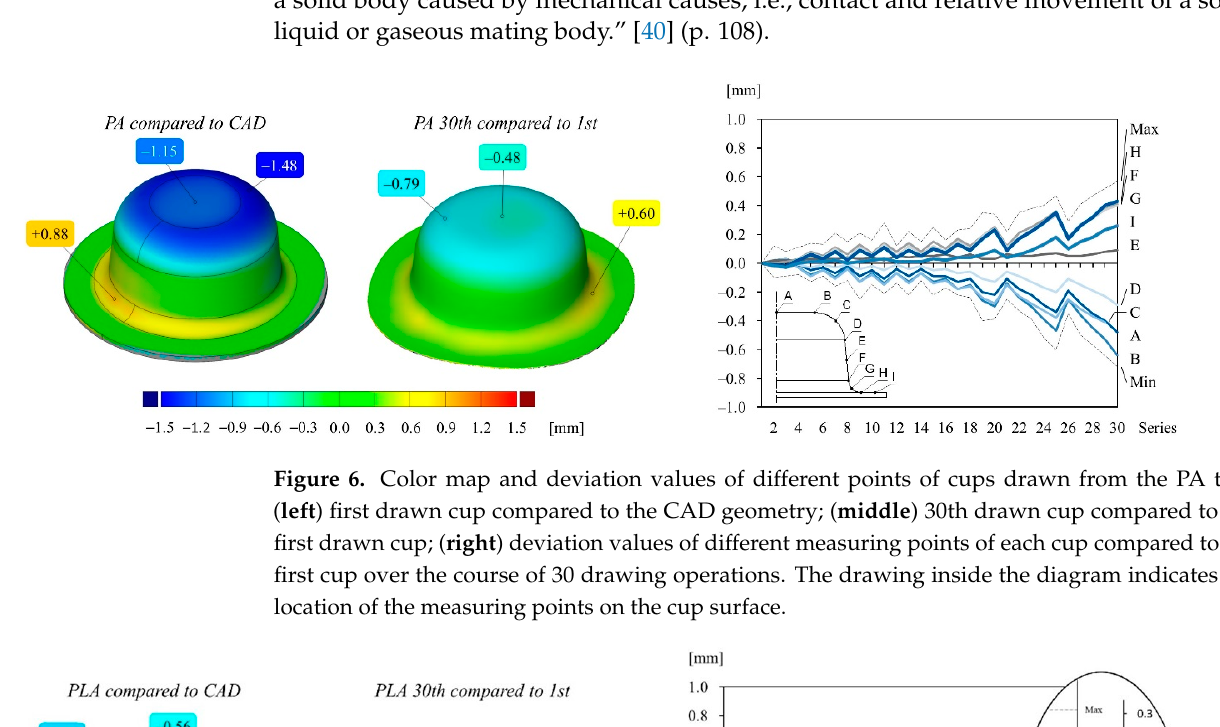
Figure 7. Color map and deviation values of different points of cups drawn from the PLA tool: ( left ) first drawn cup compared to the CAD geometry; ( middle ) 30th drawn cup compared to the first drawn cup; ( right ) deviation values of different measuring points of each cup compared to the first cup over the course of 30 drawing operations. The drawing inside the diagram indicates the location of the measuring points on the cup surface.